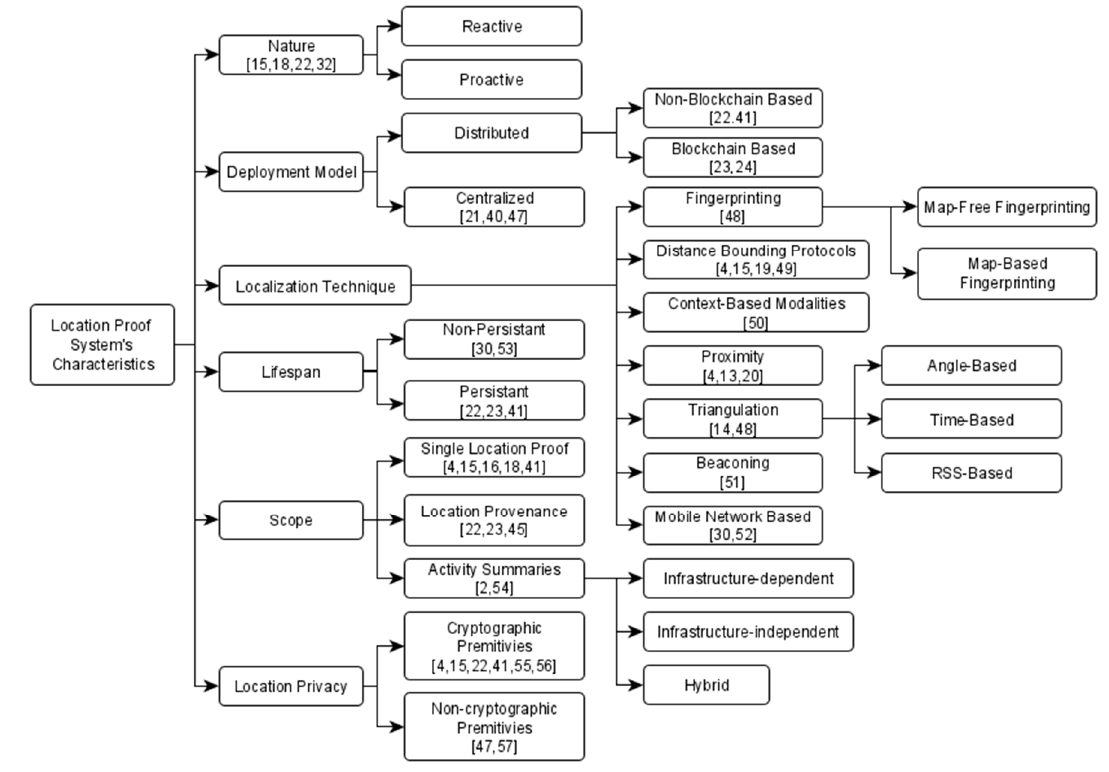
Figure 2. Taxonomy of location proof systems.